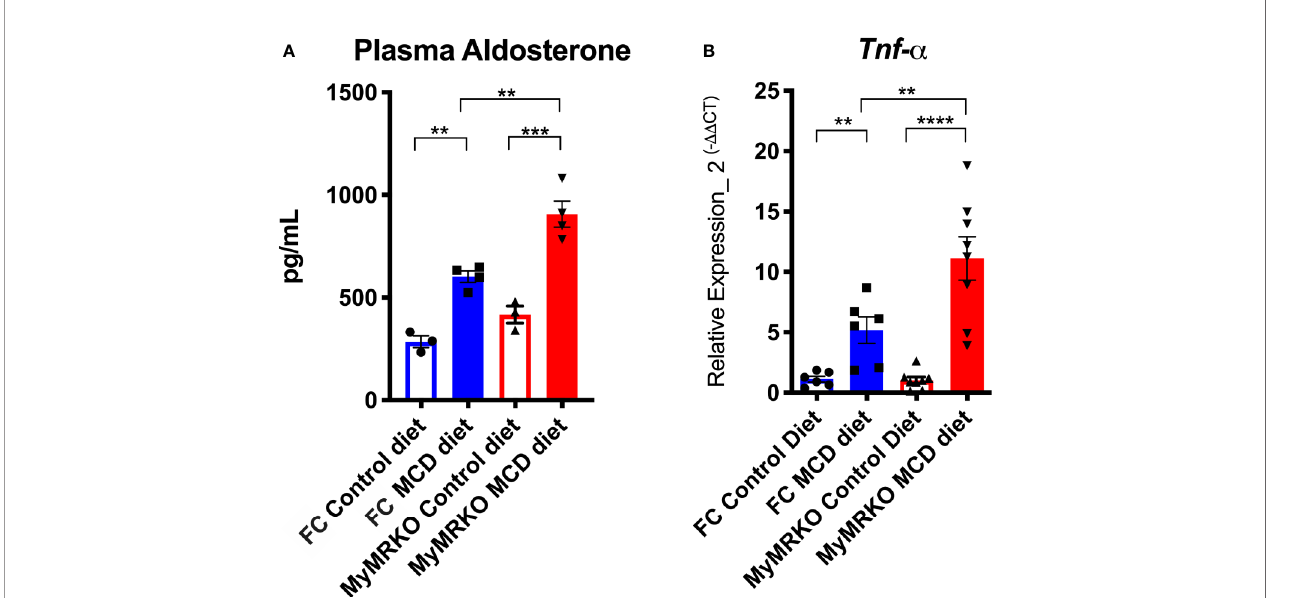
FIGURE 3 | Floxed control (FC) and myleoid mineralocorticoide receptor knockout (MyMRKO) fed with methionie and choline de fi cient diet (MCD) diet have increased plasma levels of aldosterone and related in fl ammatory genes. At the experimental endpoint, aldosterone plasma levels were quanti fi ed in all experimental groups, as shown in (A) . Then, we measured whether genes associated with high levels of aldosterone were positively modulated (B) . Tnf- a expression was quanti fi ed by RT-PCR. 18S was used as a housekeeping gene. To quantify aldosterone, it was necessary to pool plasma from two mice per group to achieve the required volume for quanti fi cation. For that reason, graphs display n=4 pooled plasma. RT-PCR was performed in duplicate from an n=7 – 8 animals per group. Statistical analysis was performed with one-way ANOVA comparing all treatments, with Tukey post-test. All fi gures display mean ± SEM. Statistical differences were considered signi fi cant according to **p < 0.01 ***p < 0.001 ****p < 0.001 ****p <